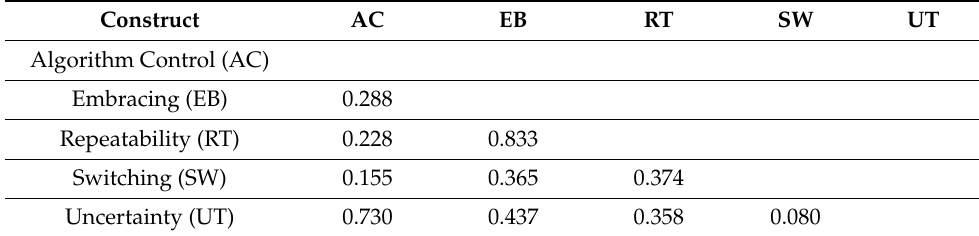
Table A4. Heterotrait–Monotrait Ratio (HTMT).